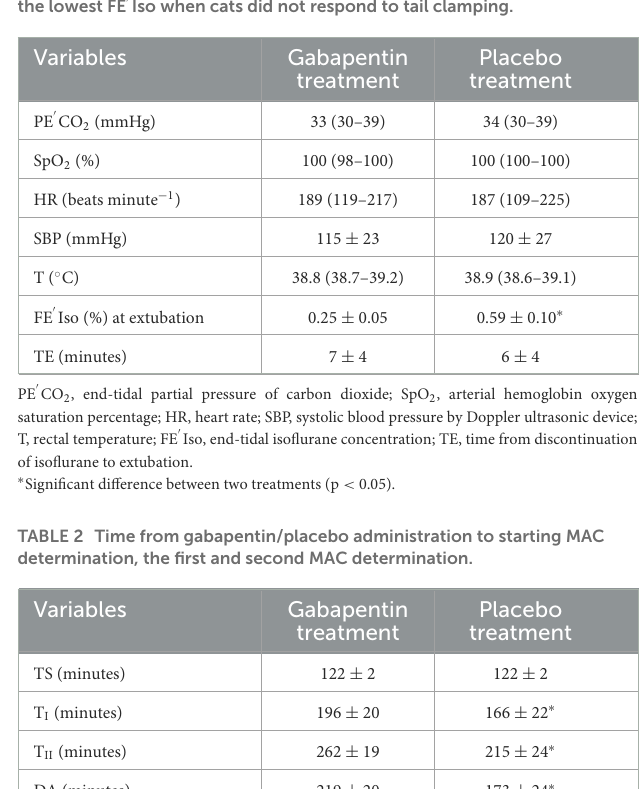
TABLE 1 Values for cardiovascular and other vital variables for six cats anesthetized with isoflurane after oral administration of gabapentin (100mg cat − 1 ) or empty capsules 2h before starting MAC determination; cardiovascular and other vital variables were obtained after equilibration at the lowest FE ′ Iso when cats did not respond to tail clamping.